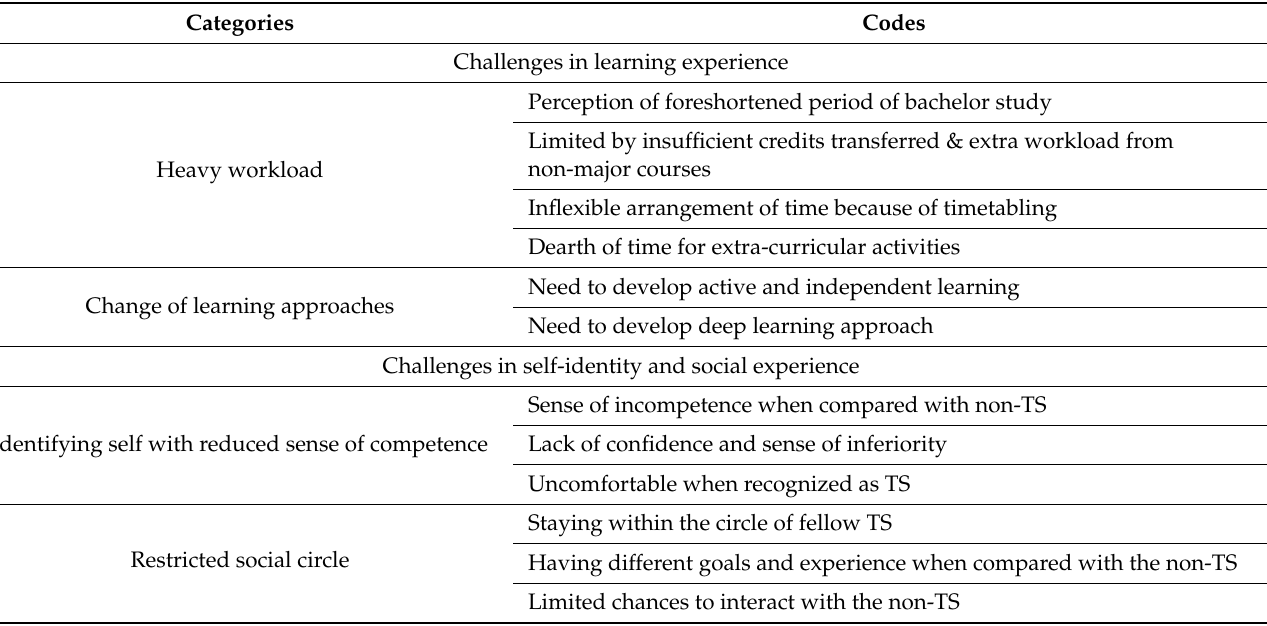
Table 2. Categories and codes of the interview